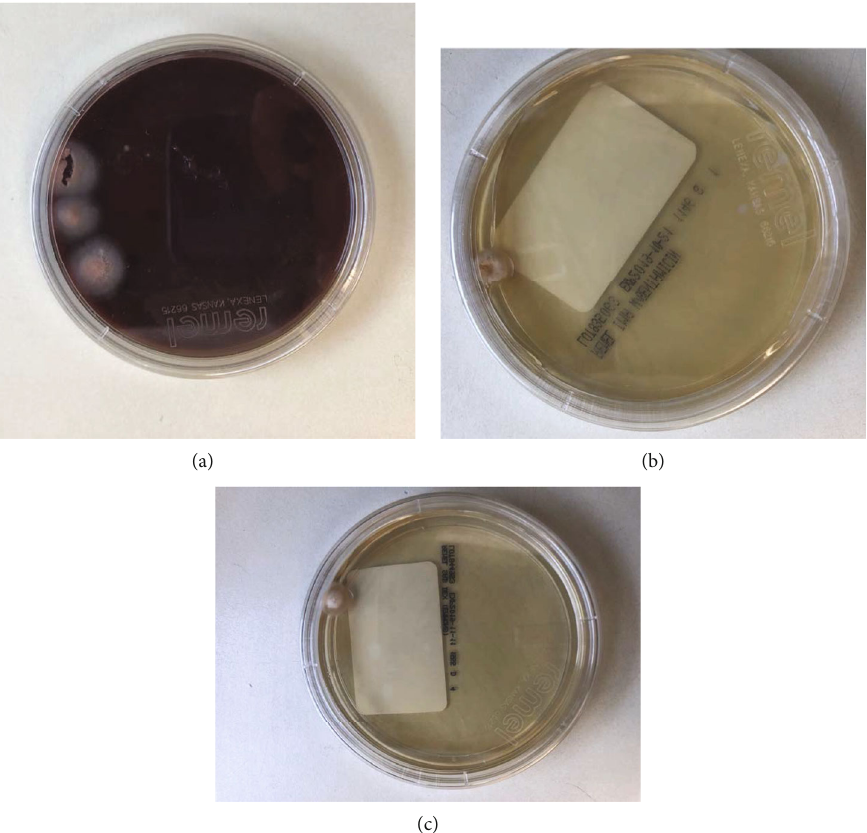
Figure 6: (a) Right knee joint aspirate on BHI agar. (b) Right knee joint aspirate on IMA agar. (c) Right knee joint aspirate on Sabouraud dextrose